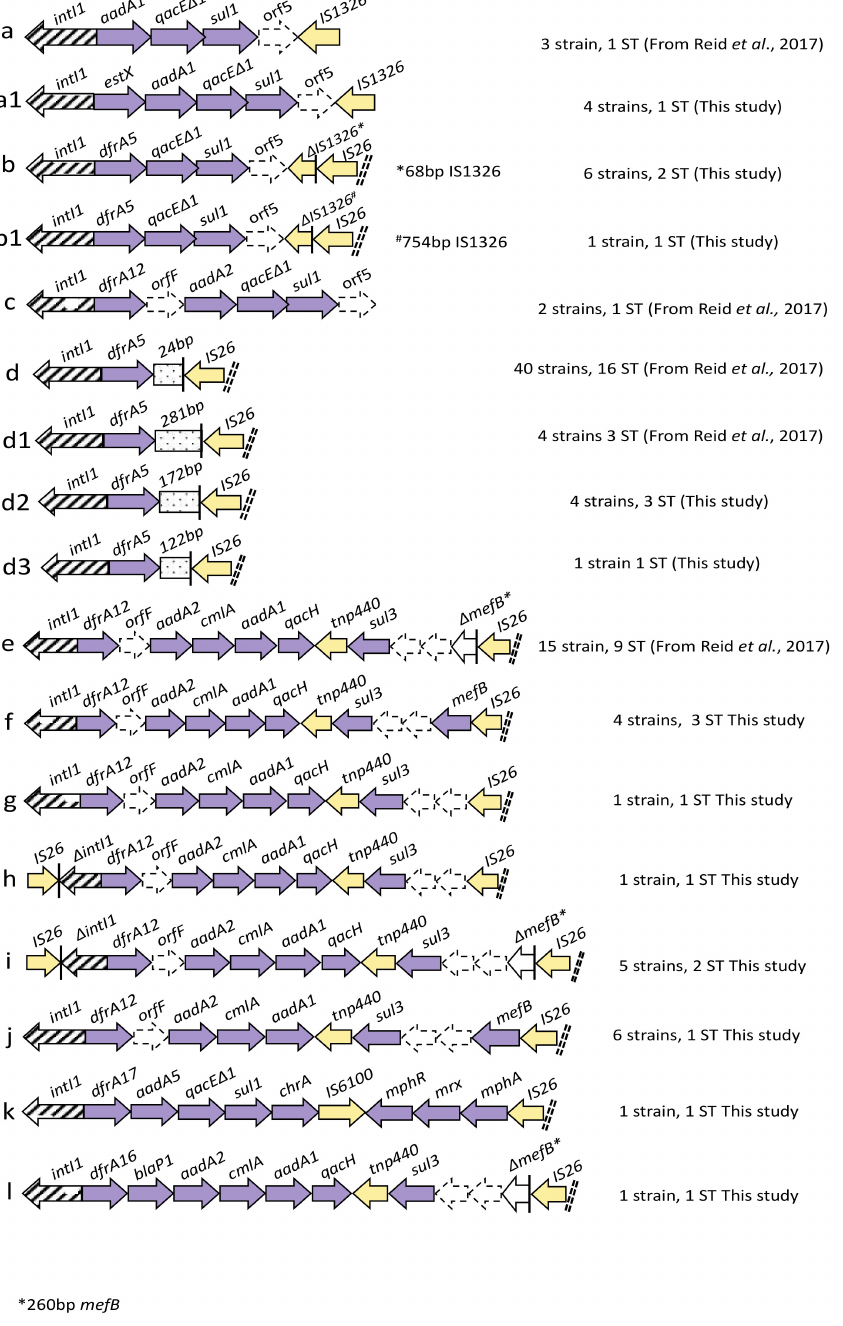
Figure 3. Schematic representation of class 1 integron structures (labeled a-l) present in the sequenced genomes. Arrows represent open reading frames (ORFs). Purple and yellow arrows represent antimicrobial resistance genes (ARGs) and insertion sequences, respectively. Arrows with dashed lines indicate hypothetical proteins. Diagonal dashed double lines represent sca ff old breaks in the